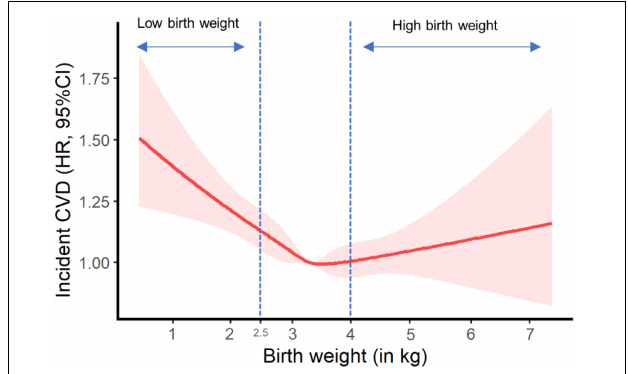
FIGURE 1 | Plot of incident cardiovascular disease risk against birth weight. HR, hazard ratio; CI, confidence interval; NSAID, non-steroidal anti-inflammatory drug. Results were adjusted for age, sex, ethnicity, Townsend Deprivation Index, education, BMI, physical activity, smoking status, alcohol consumption, vegetable and fruit consumptions, maternal smoking, breastfed as a baby, part of multiple birth, aspirin use, non-aspirin NSAID use, vitamin, mineral and other dietary supplement use, hypertension, diabetes, dyslipidemia.